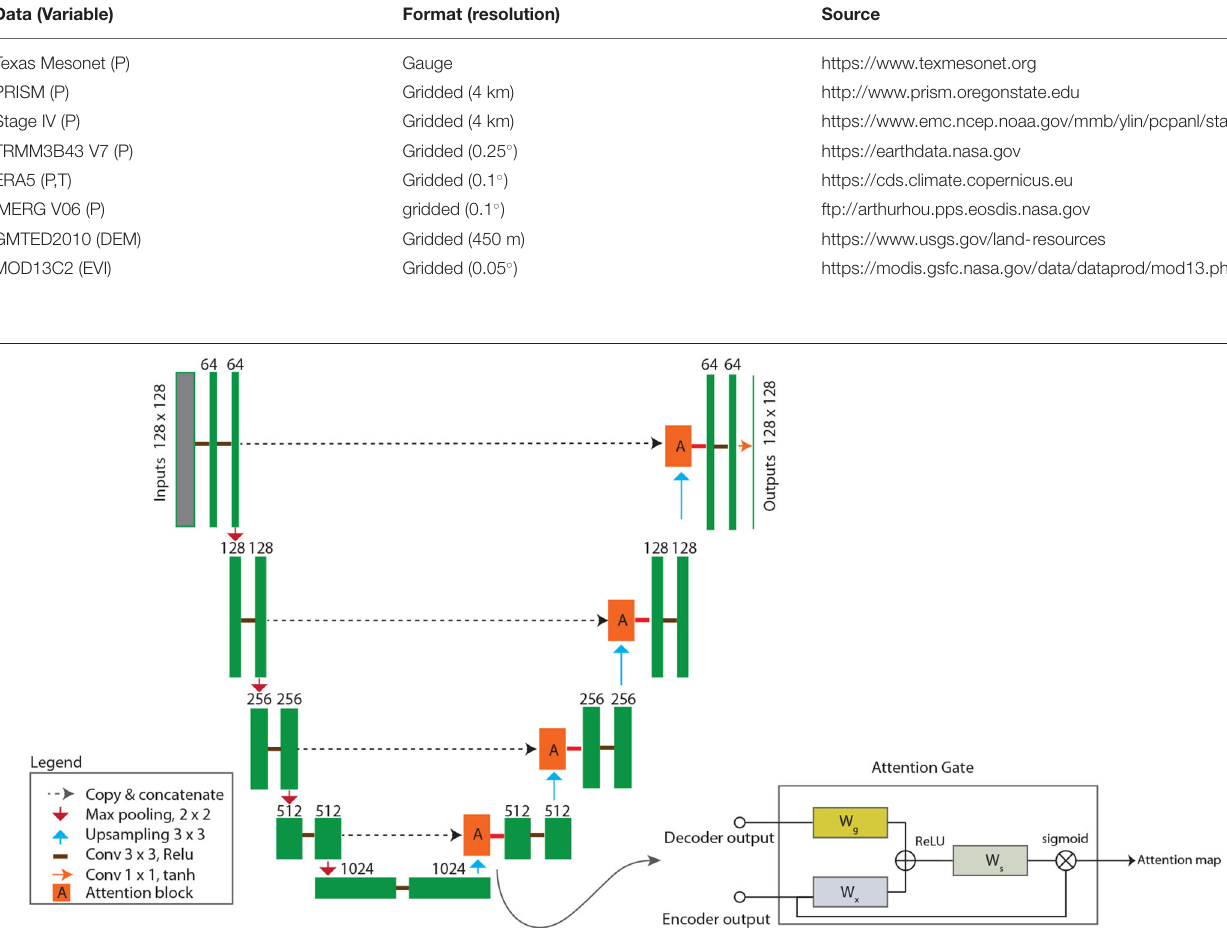
linear unit (ReLU) is used as the activation function for all hidden layers except in the output layer, where the hyperbolic tangent function (tanh) is used. The pooling size is 2 so that the input layer dimension is halved after each pooling